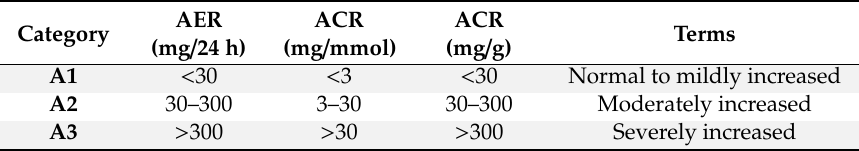
Table 2. Albuminuria categories in